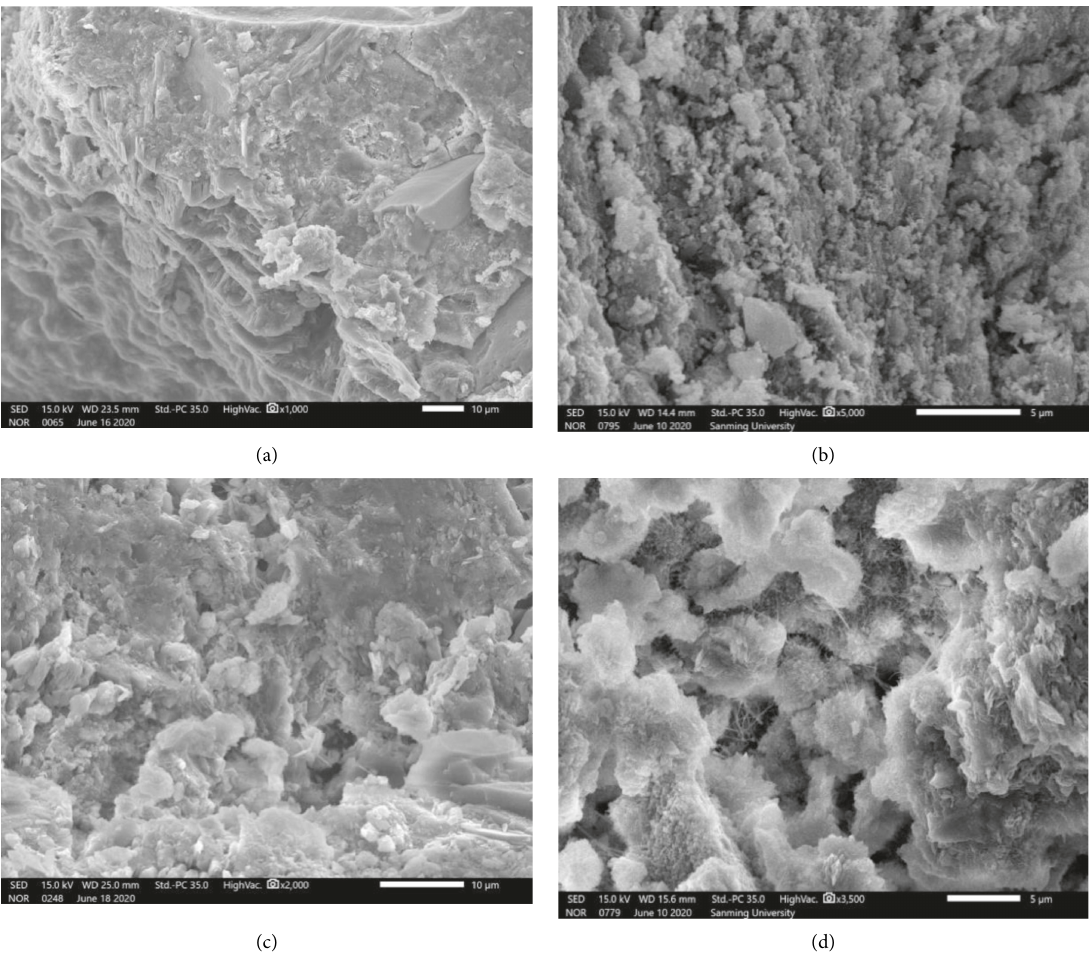
Figure 9: The microscopic morphology with the age of 7 d, (a) 0% steel slag powder mixed amount, 15% steel slag powder mixed amount, (b) 10% steel slag powder mixed amount, (c) 15% steel slag powder mixed amount, and (d) 20% steel slag powder mixed